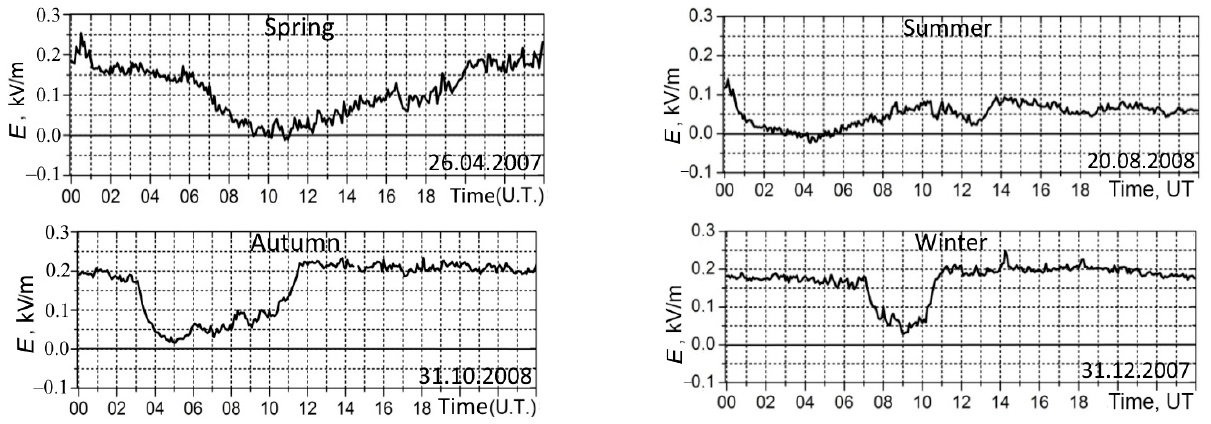
Figure 2. Diurnal variations in the electric field at the high-mountain Tien-Shan station under “fair weather” conditions for different seasons.